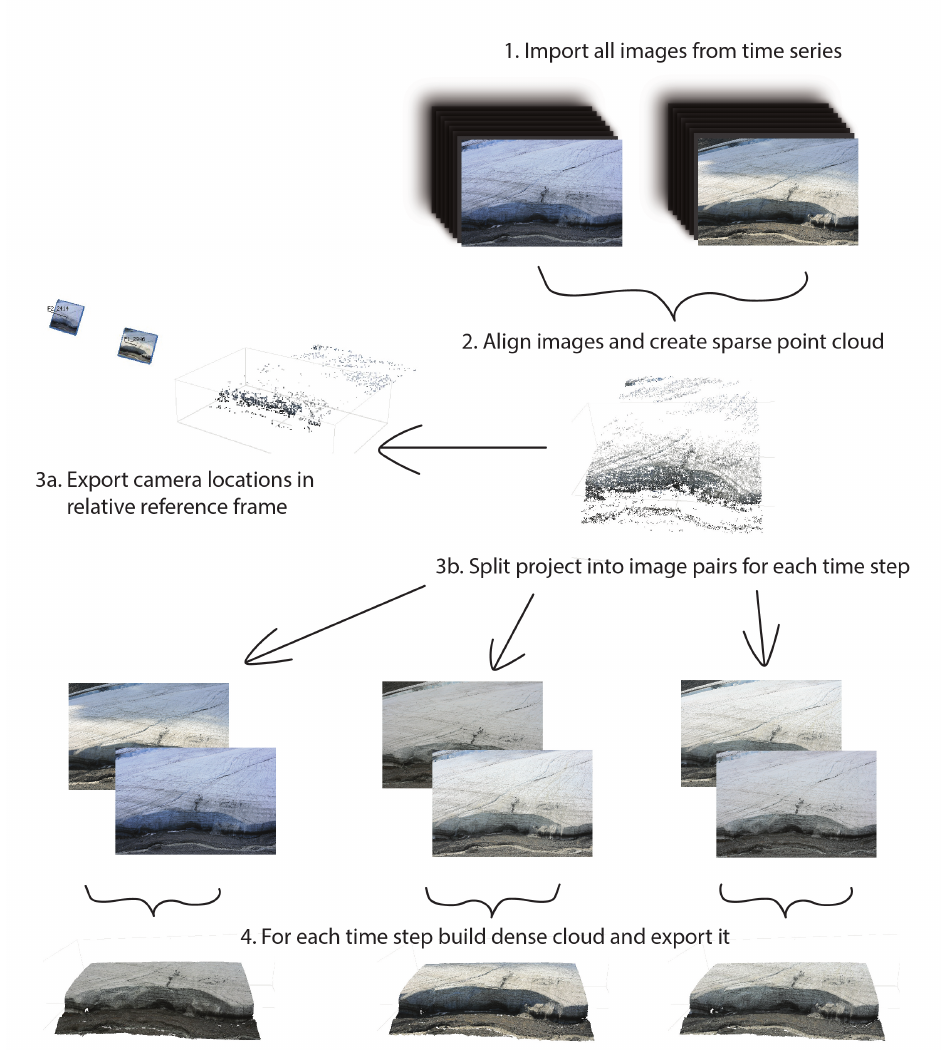
Figure 4. Workflow of SfM processing. ( 1 ) All images from both cameras are input into one Agisoft Metashape project for initial camera alignment and sparse cloud creation ( 2 ). The camera locations in the relative reference frame are exported (( 3a ) can be performed at any point after 2). The camera alignment and sparse cloud are copied into separate projects for each time step and images from other time steps are removed ( 3b ). The dense cloud is built at each time step based on the camera alignment from all images, but the image depths from only that time step ( 4